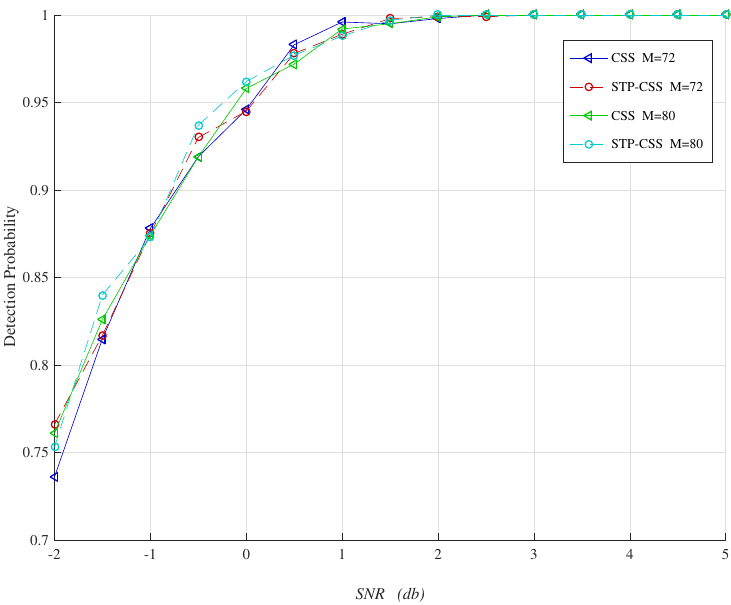
Figure 7. Comparison of the reconstructed signal in compressed spectrum sensing (CSS) and STP-CSS, where the numbers of the measurement matrix were set to 72 and